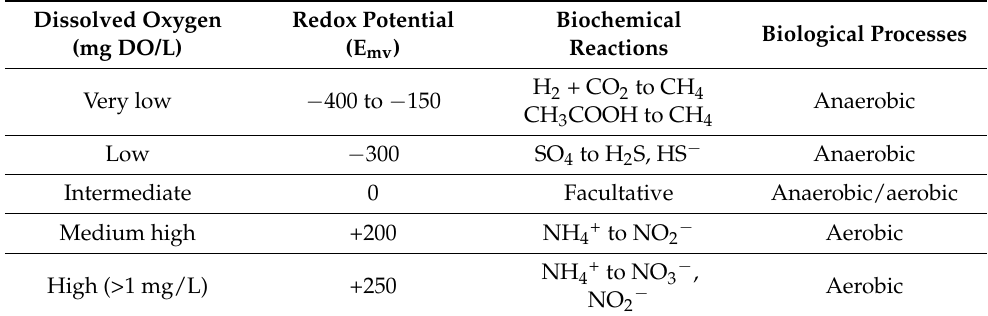
Table 3. Different biochemical processes under different concentrations of dissolved oxygen (DO), and redox potential